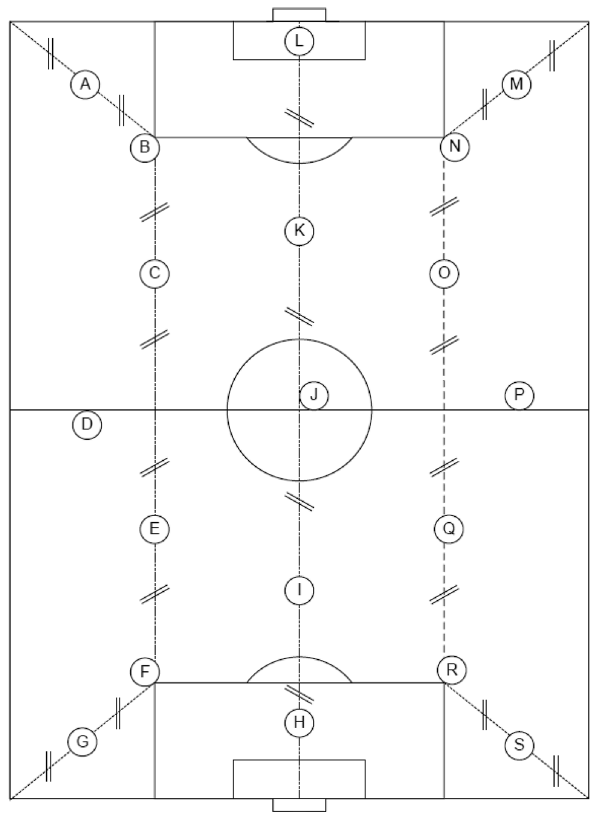
Figure 3. Test zones according to regulation FIFA Test Methods 2015 (FIFA,